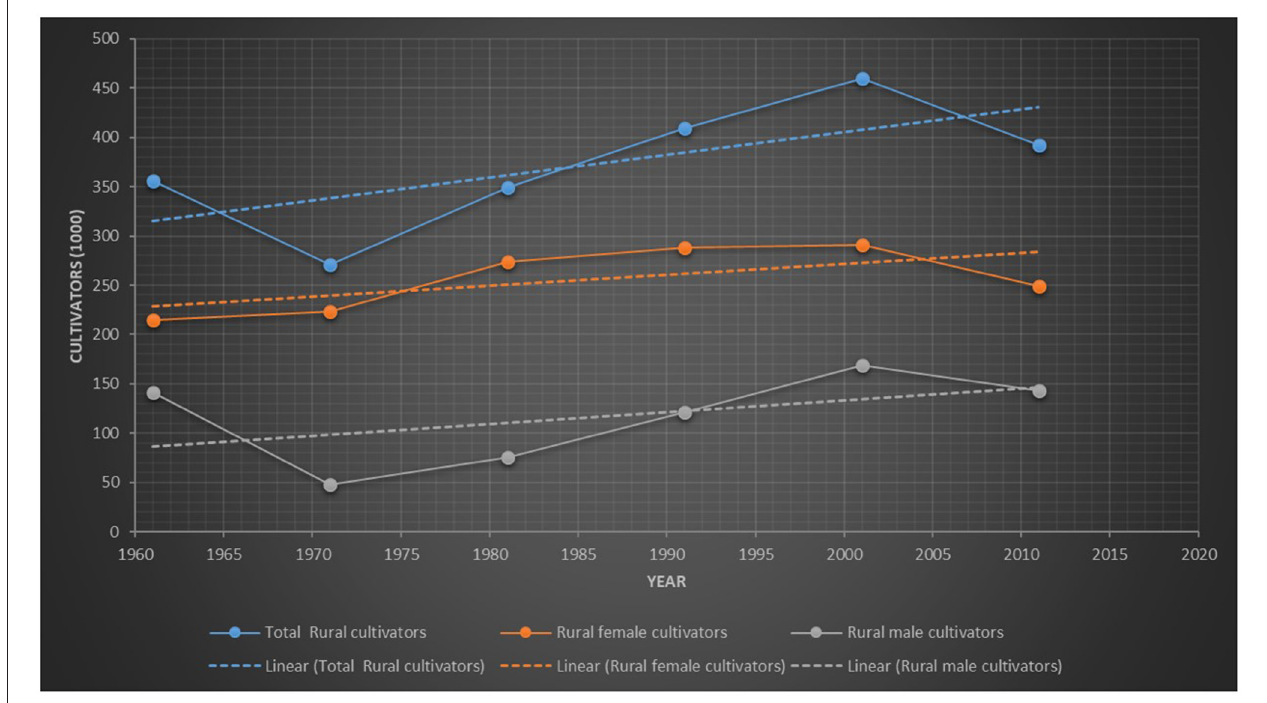
FIGURE 3 | Male and female cultivators (farmers) in Warangal rural district. Source: ICRISAT District-Level Data